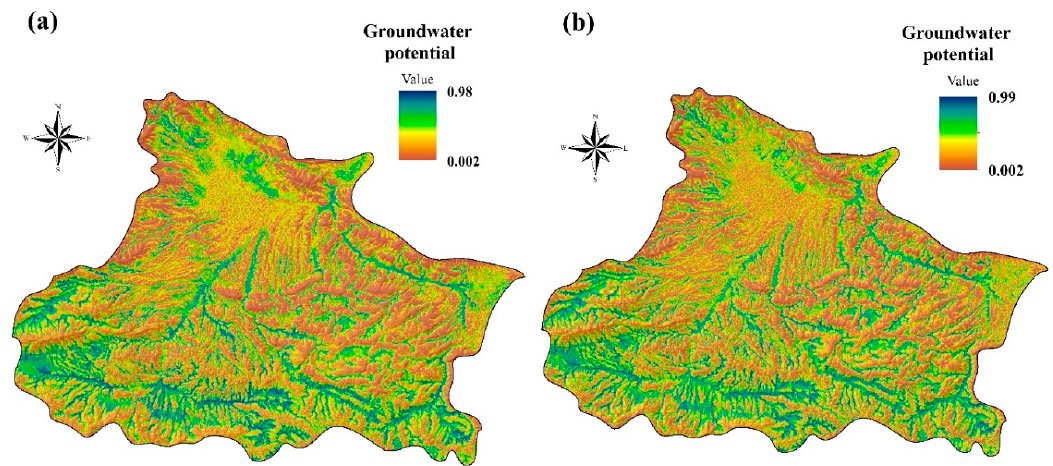
Figure 9. Groundwater potential maps of the study area produced using the random forest (RF) model and based on: ( a ) the simple random method, and ( b ) the selection of absence samples (SAS) method.